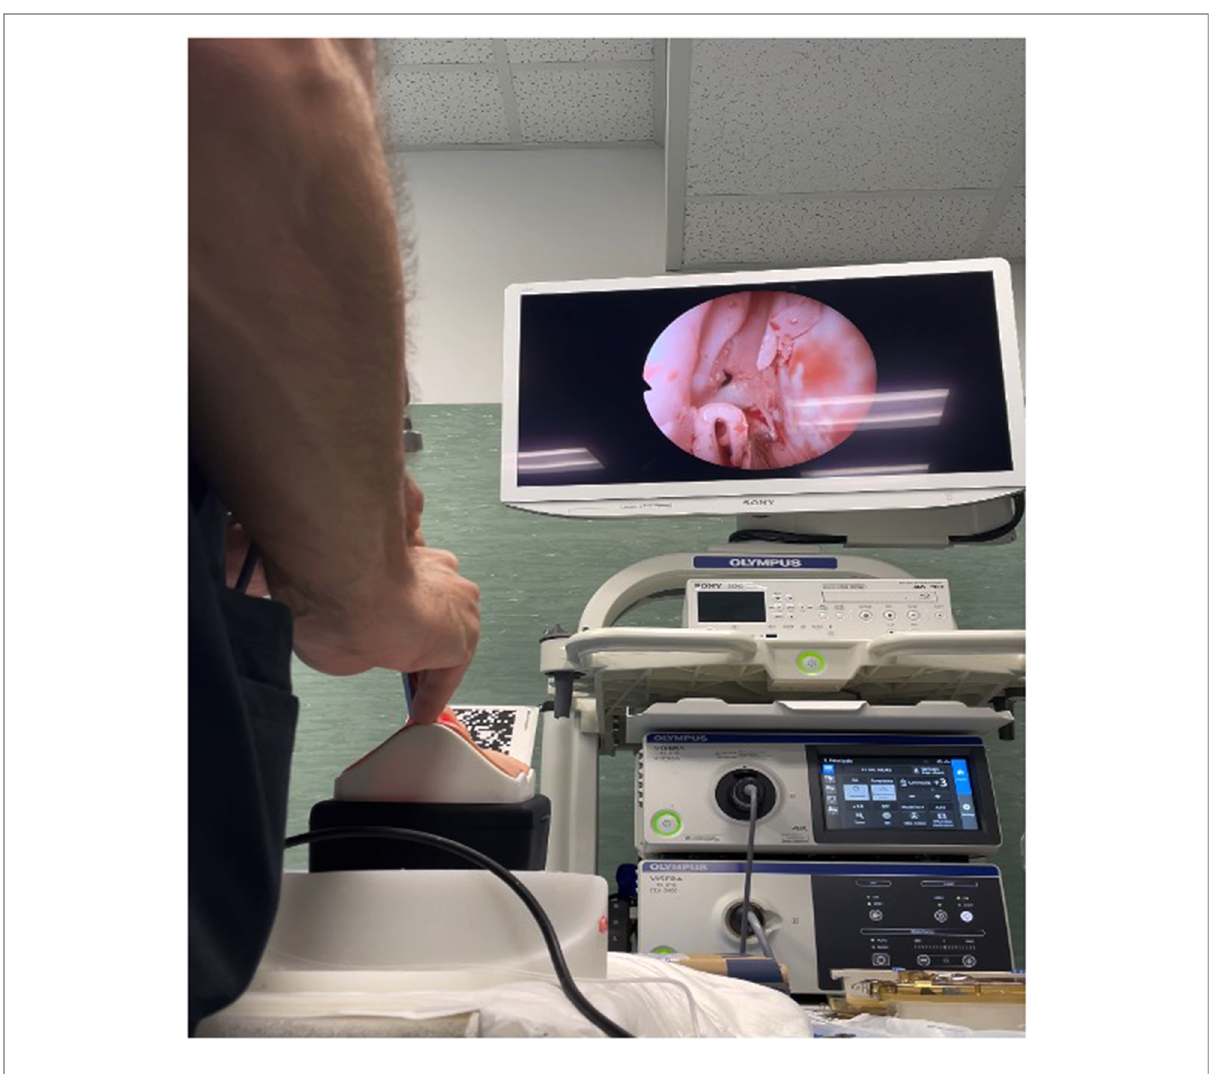
FIGURE 2 Workstation set up with the UpSurgeOn TNS Box and endoscope.